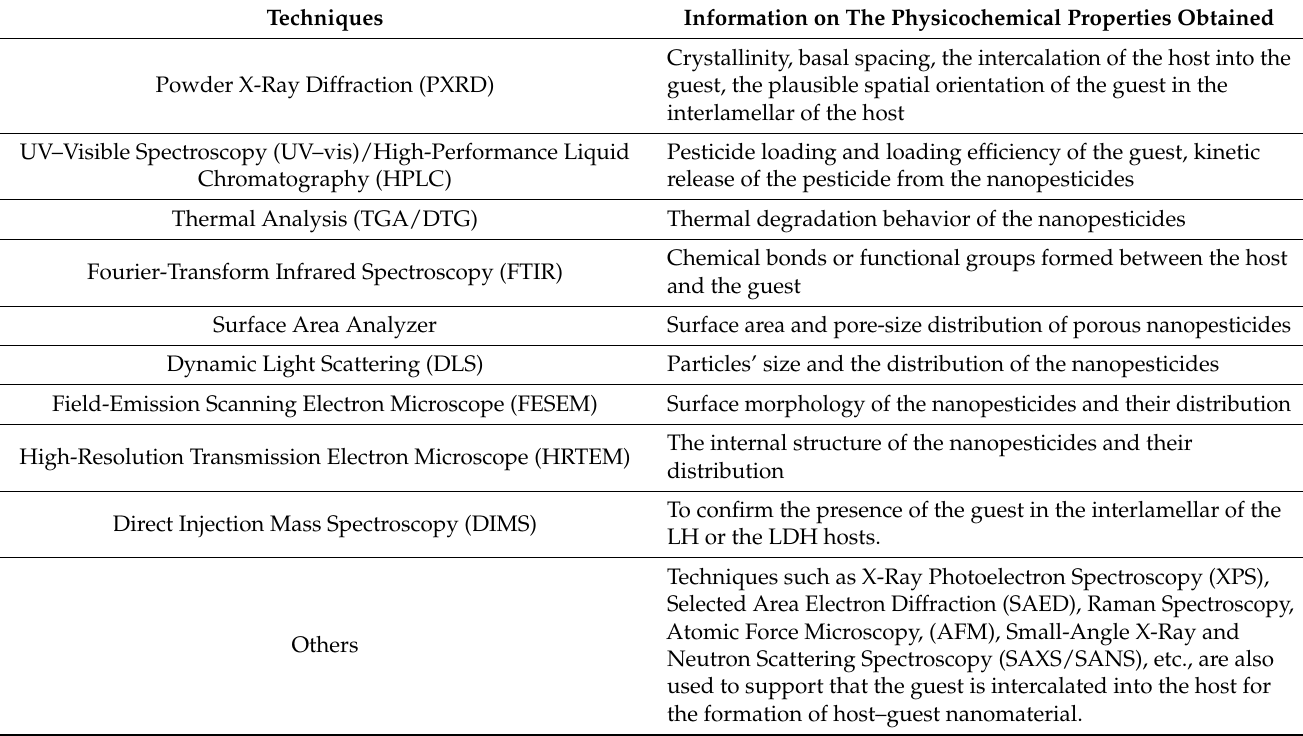
Table 2. Some important physicochemical characterizations of the nanopesticides synthesized by host–guest supramolecu- lar